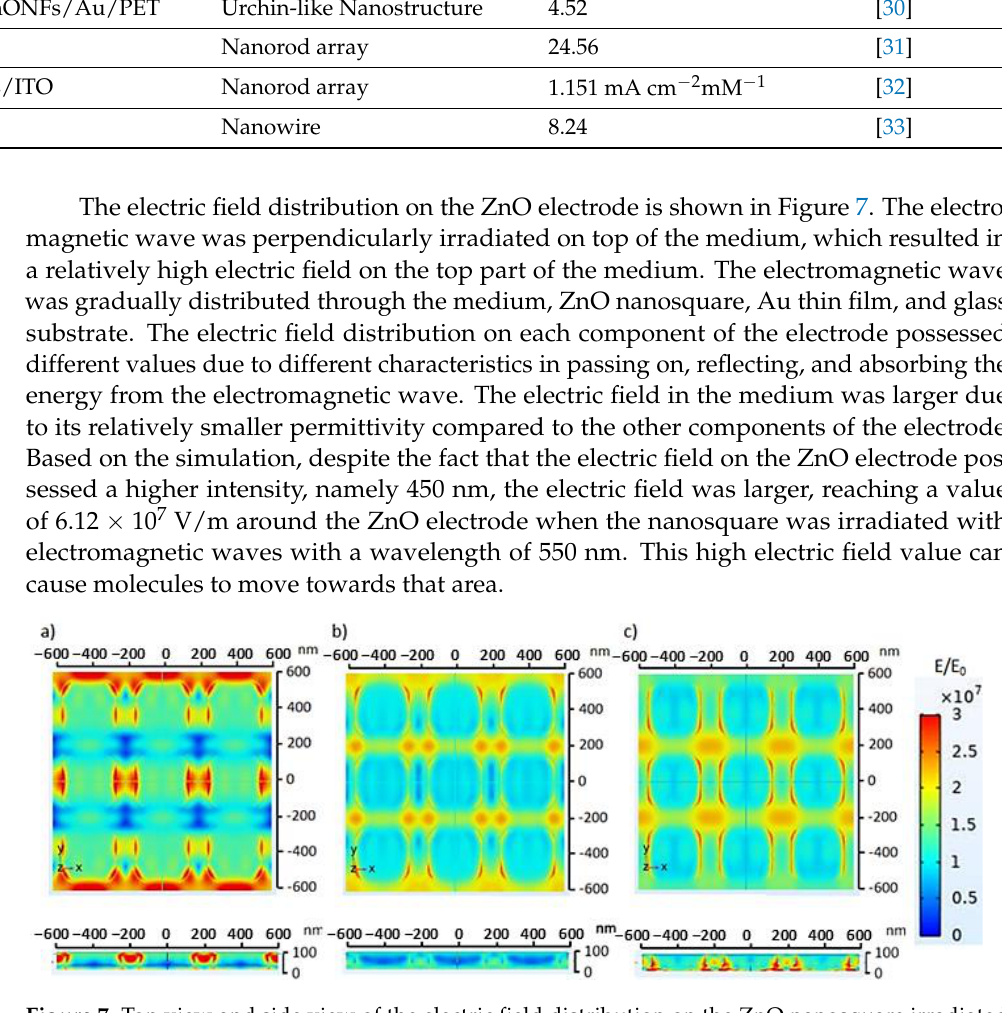
Table 1. Comparison of the glucose sensor performance based on ZnO.